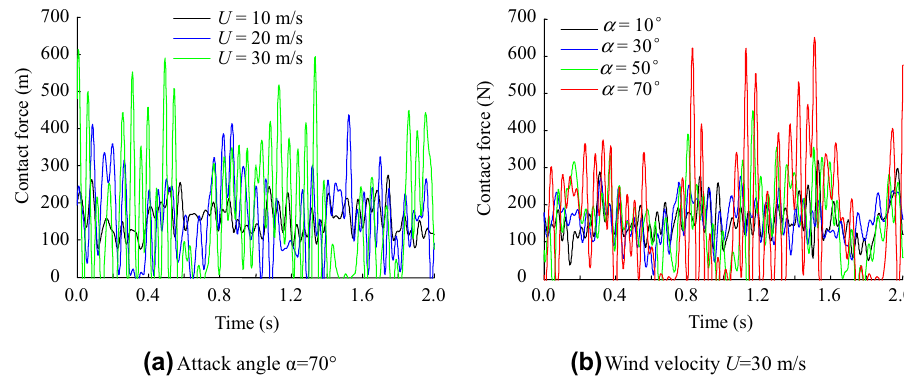
Fig. 10 Contact force under different wind velocities ( a ) and attack angles ( b ) (train speed is